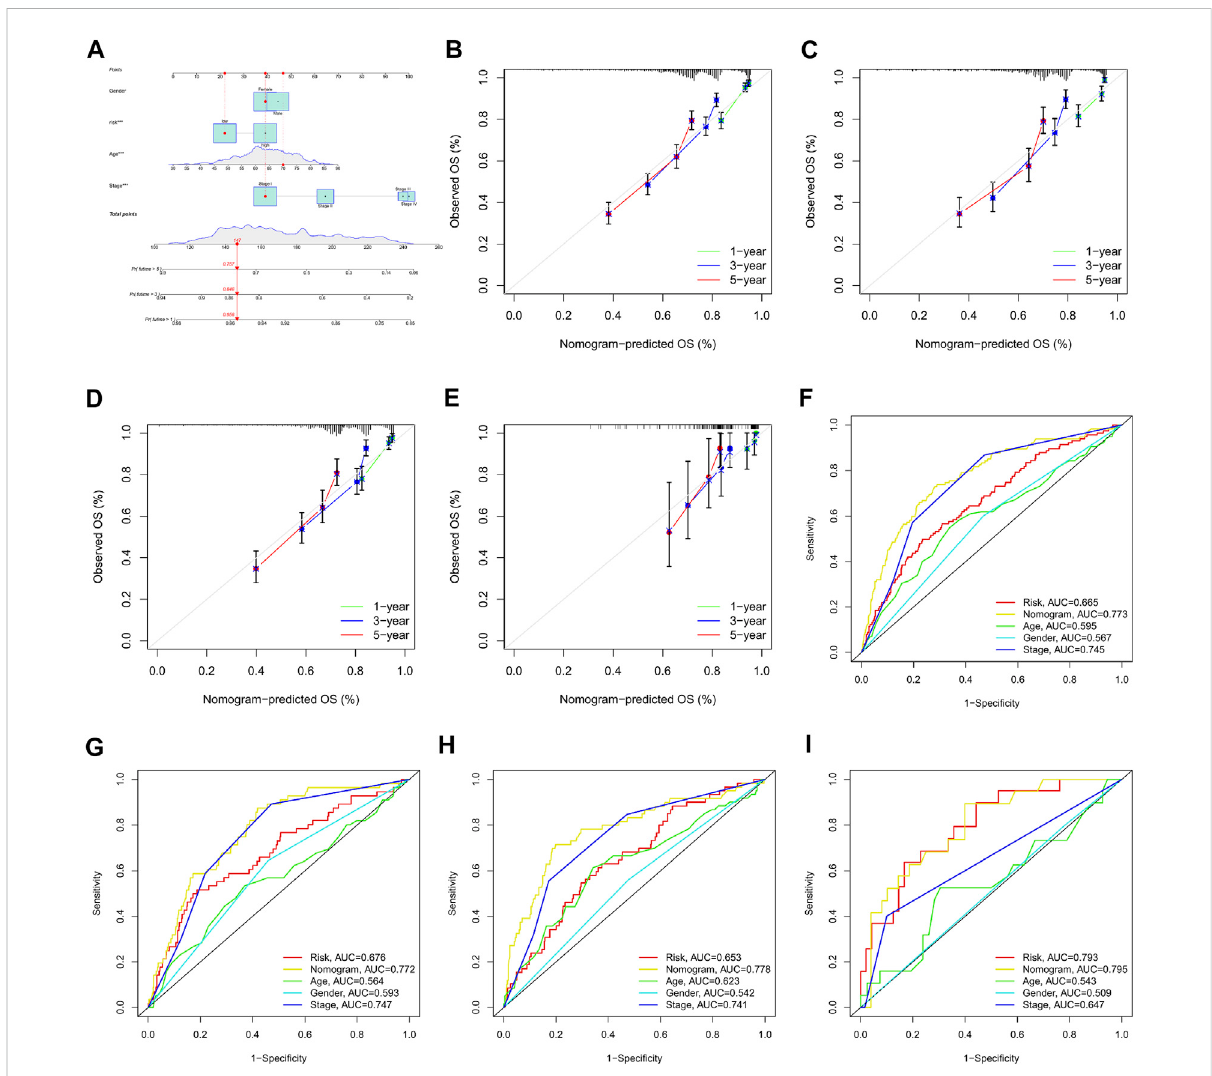
FIGURE 12 Establishment and validation of nomogram for clinical prediction. (A) Nomogram establishment. (B – E) Calibration curves for 1-, 3-, and 5-year OS in the total, training, test, and GSE30219 sets. (F – I) ROC curves for 1-, 3-, and 5-year OS in the total, training, test, and GSE30219